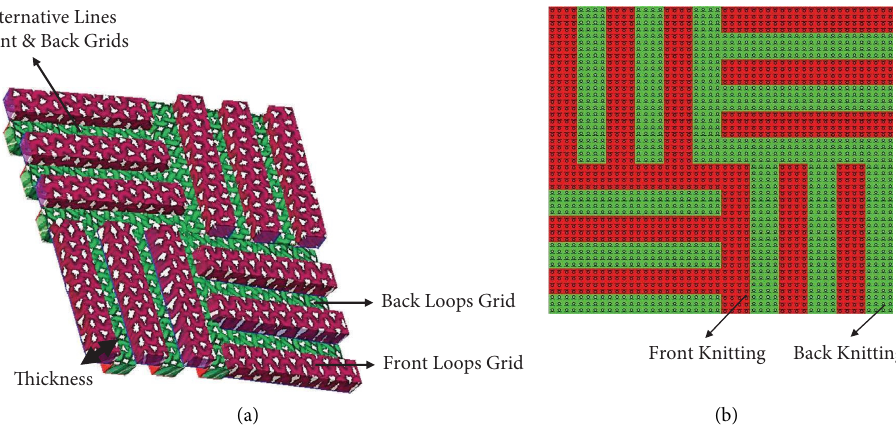
Figure 2: (a) 3D diagram of line structure and (b) knitting notation of line structures.